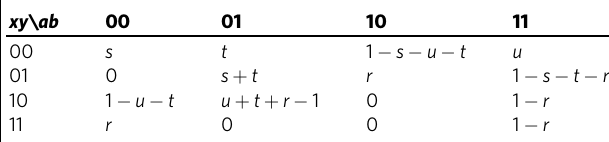
Table 2 Parametrization of two-input two-output no- signaling boxes with singular disagreement. Here, r , s , t , u , ∈ [0, 1] are such that all the entries of the box are non-negative, s > 0, and s + t ≠ 0 and u + t ≠